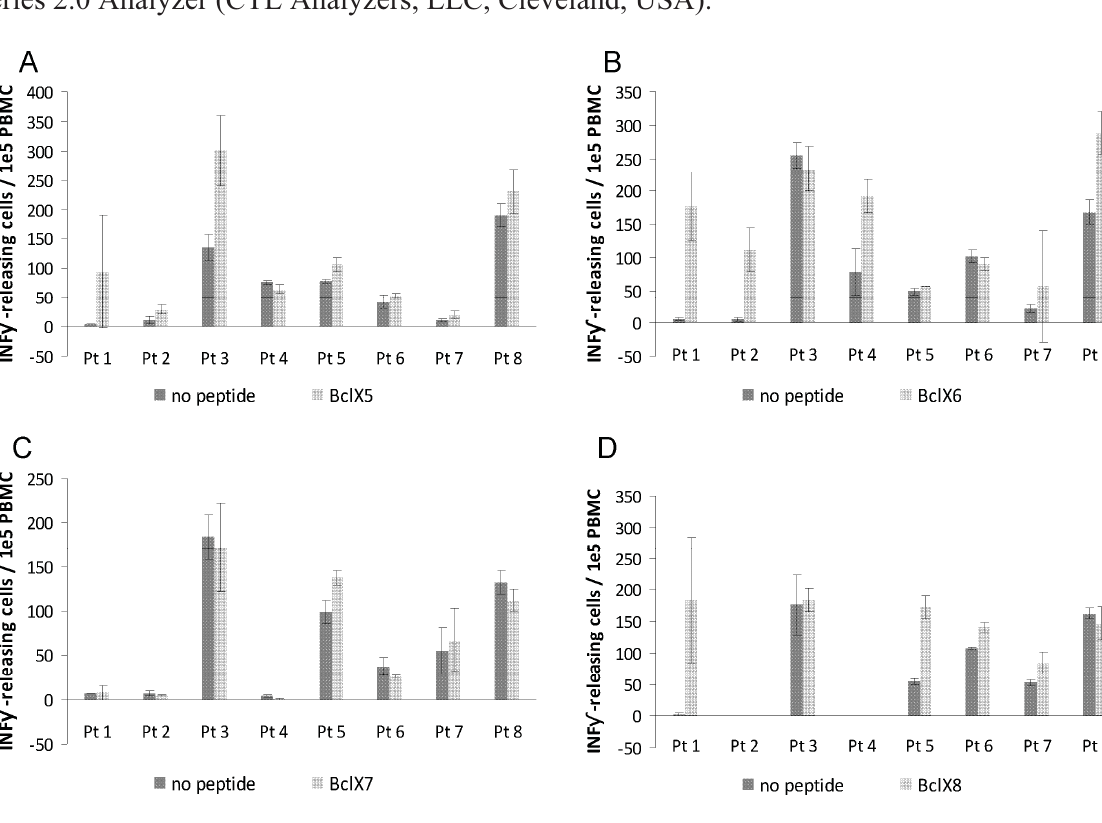
Figure 3. T-cell responses against Bcl-X(L) as measured by IFN- (cid:3) ELISPOT. PBMC from eight melanoma patients were analyzed. The peptides Bcl-X5 (LCVESVDKEMQVLVSRI AAW) (A) , Bcl-X6 (EMQVLVSRIAAWMATYLNDH) (B) , Bcl-X7 (IAAWMATYLND HLEPWIQEN) (C) , and Bcl-X8 (LNDHLEPWIQENGGWDTFVELYG) (D) were examined. T-lymphocytes were stimulated once with peptide before being plated at 10 5 cells per well in duplicates either without or with peptide. The number of IFN- (cid:3) without ( dark grey ) or with ( light gray ) added peptide was calculated for each patient using the ImmunoSpot® Series 2.0 Analyzer (CTL Analyzers, LLC, Cleveland, USA).